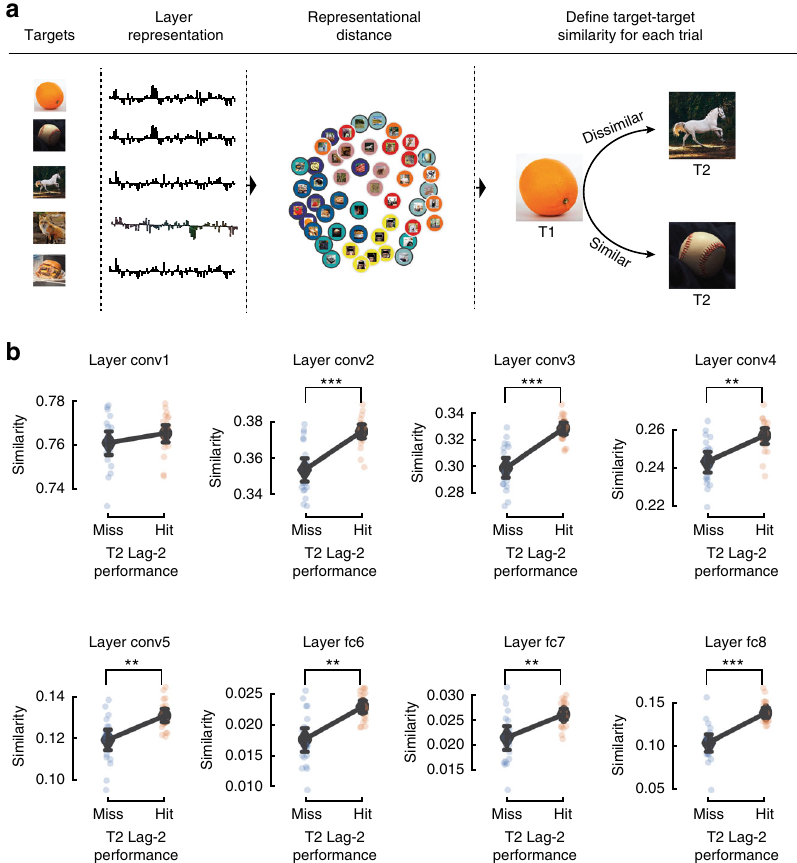
Fig. 4 DCNN representational distance and target similarity explain trials of the AB. a Depiction of analysis procedure. For each layer, DCNN representations are extracted for each image. These feature activations were then compared for all image pairs (Pearson correlation), to estimate the similarity between pairs. Due to copyright reasons, all photos except for the faces (which were photographed by one of the authors) have been replaced by representational images. b ) Mean similarity between T1 and T2, based on feature activations of each layer, for lag-2 missed and hit trials separately. Separate dots represent single subjects. The mean similarity across subjects is represented by a large black diamond and black bars denote 95% con fi dence interval. Two-tailed dependent t -test * p < 0.05, ** p < 0.01, *** p < 0.001 Table 3 Mean and SDs for T2 performance in experiment